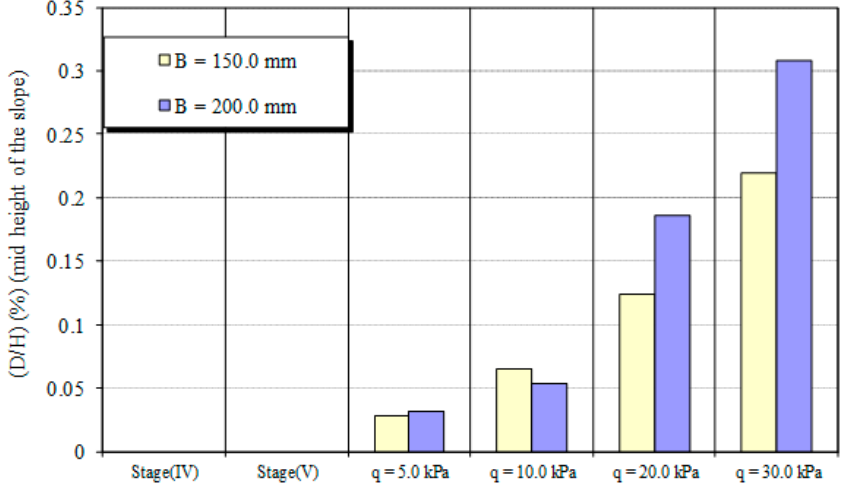
Figure 19. Influence of footing width on the horizontal movement at mid-height of slope.